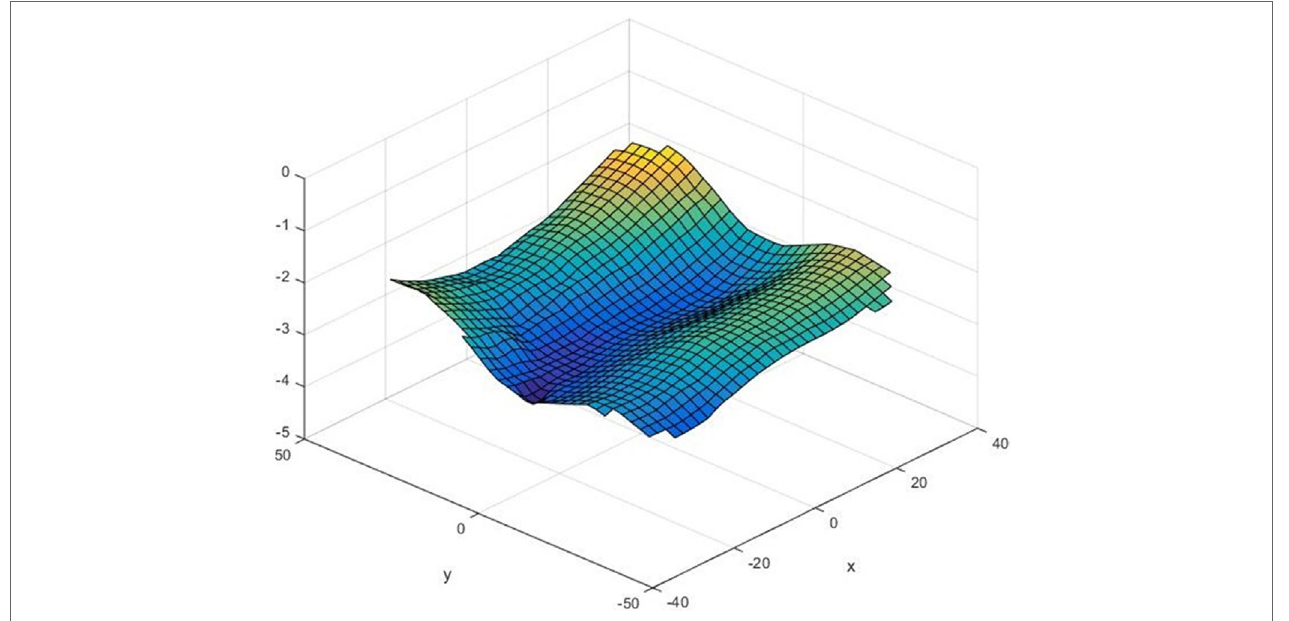
FIgURe 11 | An example of resolved 3D water surface shape. All units are in centimeters. Color added for redundancy to visualize vertical displacement.